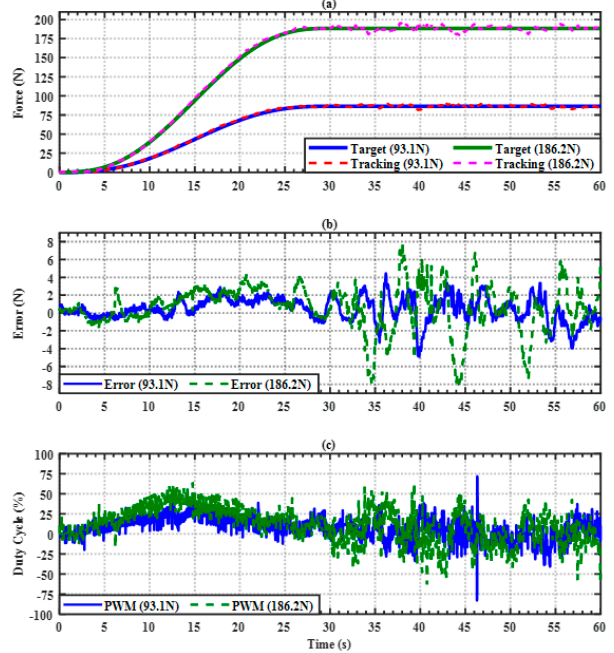
Figure 9. Dynamic bodyweight unloading force control of ILESO − PSMC, 20% (93.1 N) and 40% (186.2 N) of female subject body weight (845.5 N). ( a ) Unloading force tracking response; ( b ) unloading force tracking error; ( c ) duty cycle of PWM.